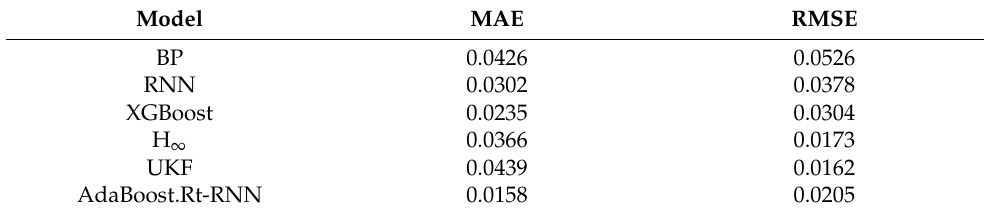
Table 2. Comparison of prediction accuracy of lithium